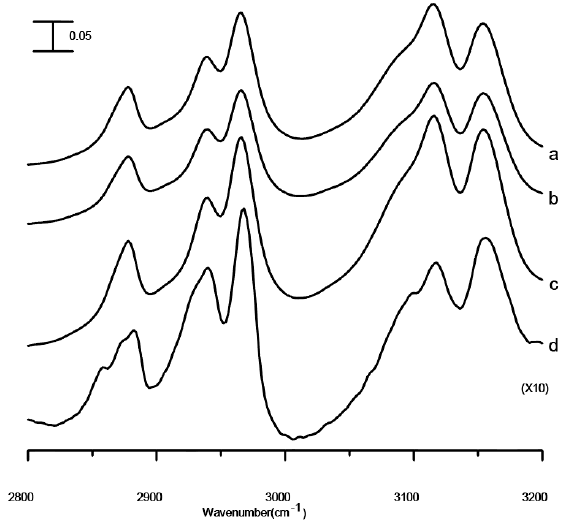
Figure 1. Infrared (IR) spectra of pure 1-butyl-3-methylimidazolium trifluoromethanesulfonate ([BMIM][TFS]) (curve a), the [BMIM][TFS]/Al 2 O 3 mixture (curve b), the mixture after two washes with ethanol (curve c), and the mixture after five washes (curve d), recorded under ambient pressure. Curve d was baseline-corrected by subtracting a straight line. Relative intensities of the IR bands are given in increments of 0.05; the scale bar is displayed in the upper left corner of the